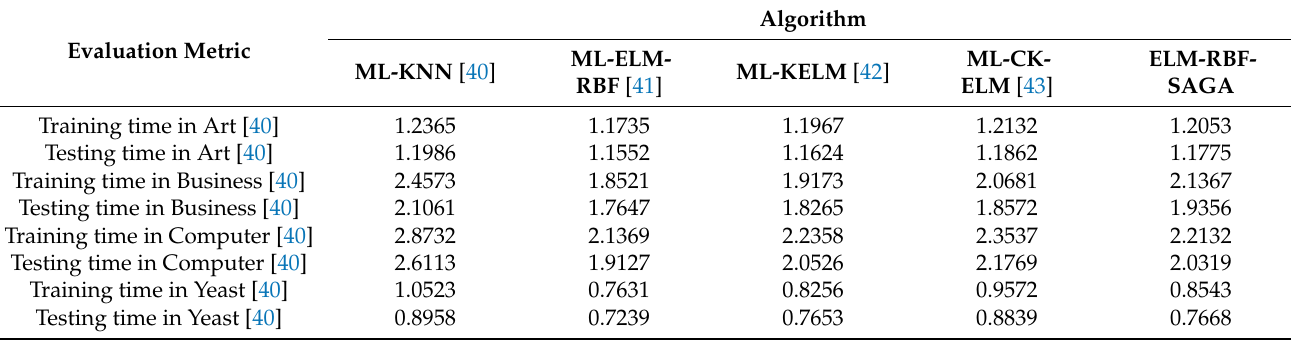
Table 9. Running time of different models in each